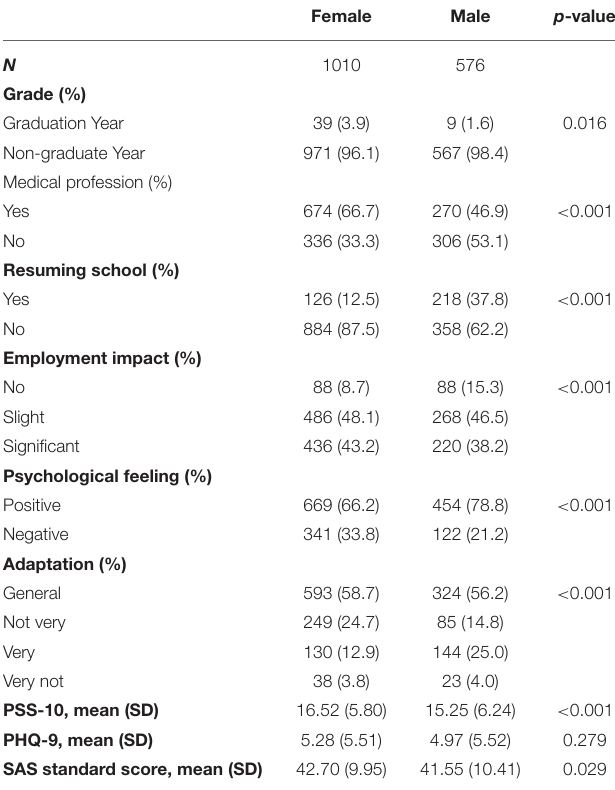
TABLE 1 | Demographic characteristics and health status of all participants. Female